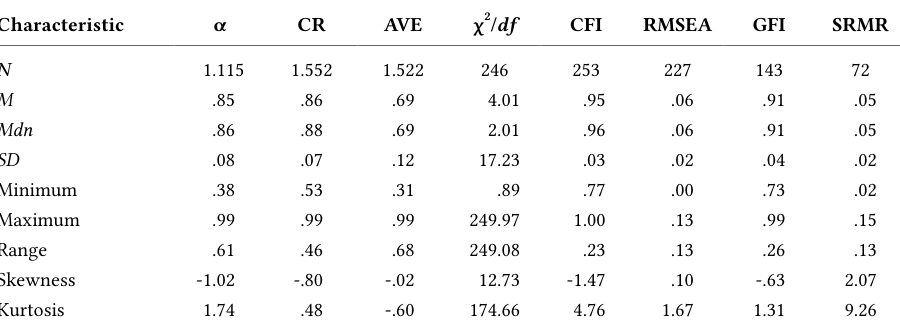
Descriptive Statistics of Reliability Indices and Model Fit